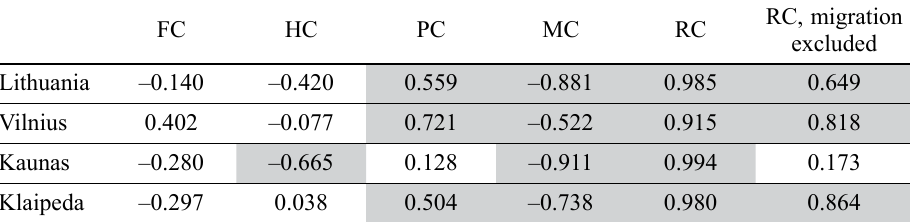
Table 4. Correlation between values of different index groups and the total index values FC HC PC MC RC